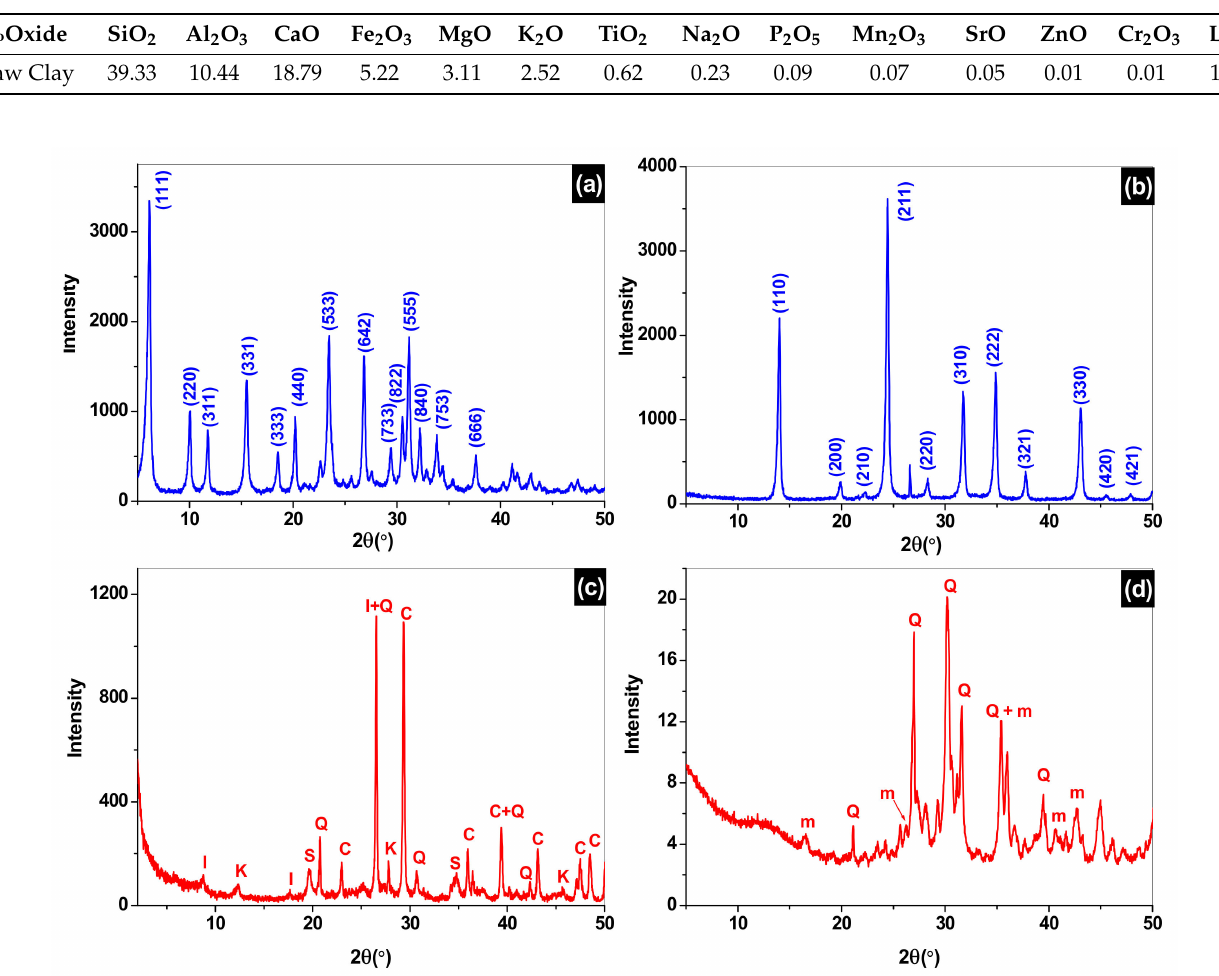
Table 1. Chemical composition of the raw clay.